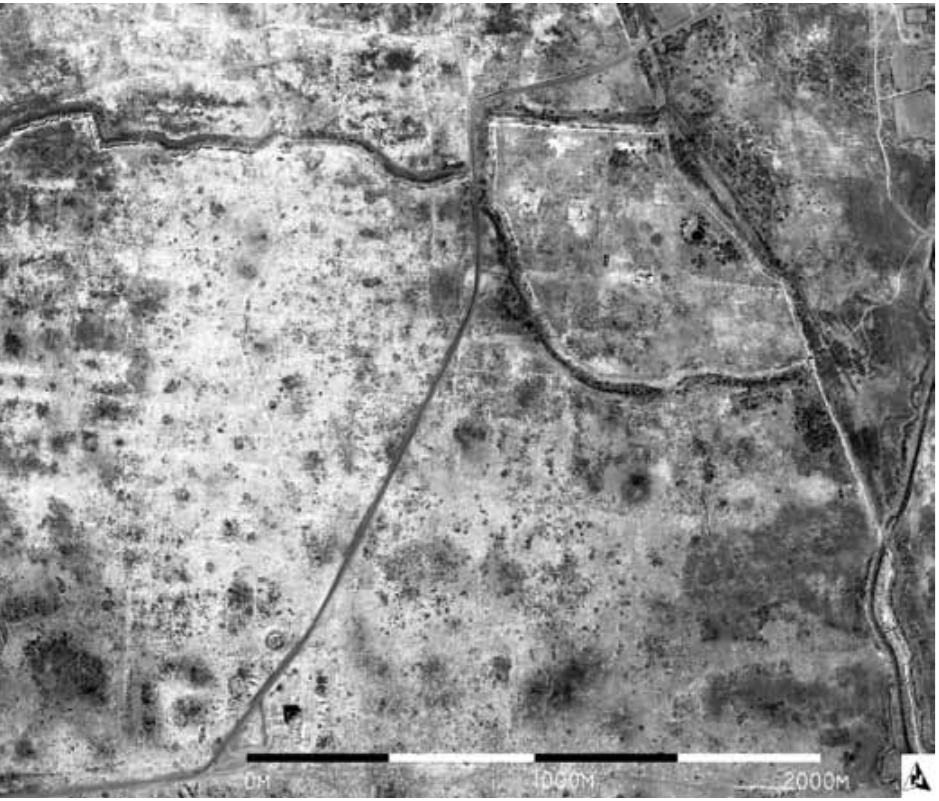
Fig. 4: Part of the IKONOS satellite image taken in April 2001, showing the north central part of Sultan Kala (broadly the same area as Fig. 3 ). Its 1m resolution does not provide the same level of detail as an AP, but the excellent quality – and the ability to geo-rectify it – provides the basis for AP